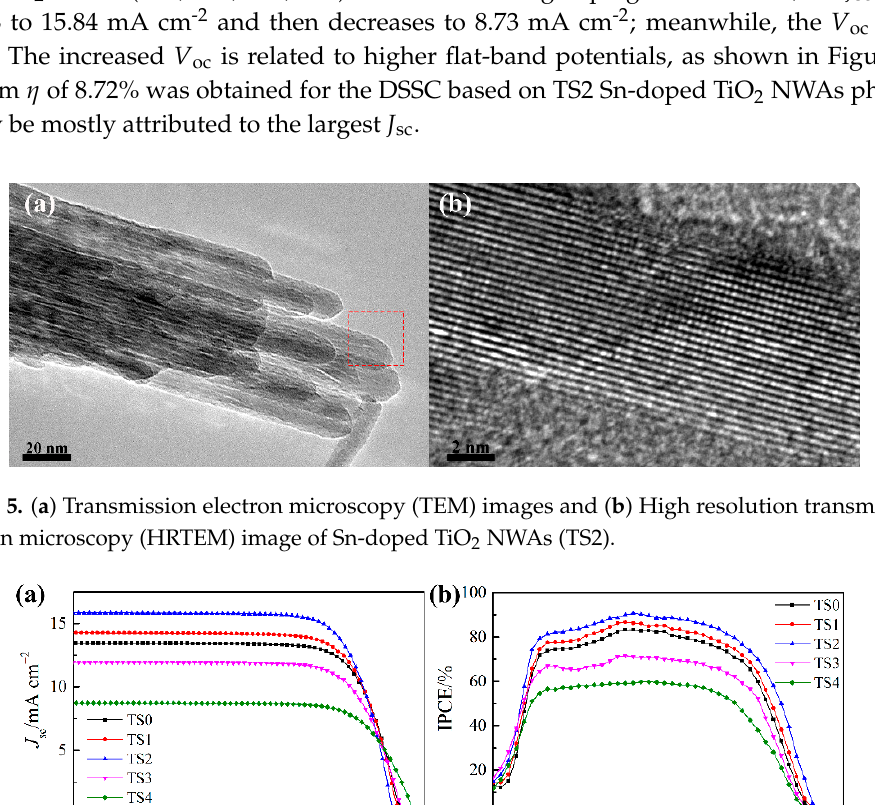
Figure 5. ( a ) Transmission electron microscopy (TEM) images and ( b ) High resolution transmission electron microscopy (HRTEM) image of Sn-doped TiO 2 NWAs (TS2).